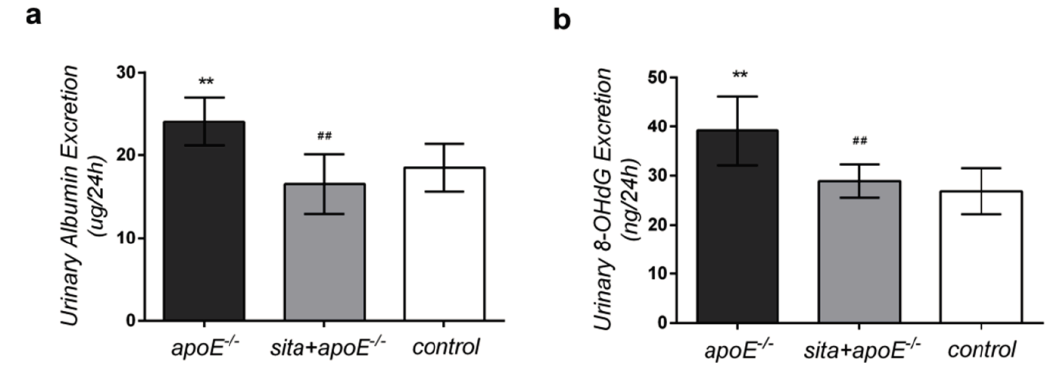
Figure 2. Effect of sitagliptin on 24-h urinary albumin and 8-hydroxy-2-deoxyguanosine (8-OHdG) excretion. ApoE − / − , sita + apoE − / − and control groups were tested at week 16 for ( a ) 24-h urinary albumin excretion; ( b ) 24-h urinary 8-OhdG excretion. Values are mean ±